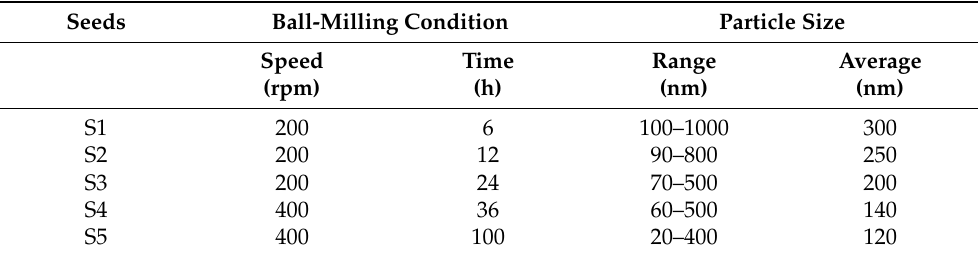
Table 1. Particles size distribution of planetary-milled seeds at various conditions. Seeds Ball-Milling Condition Particle